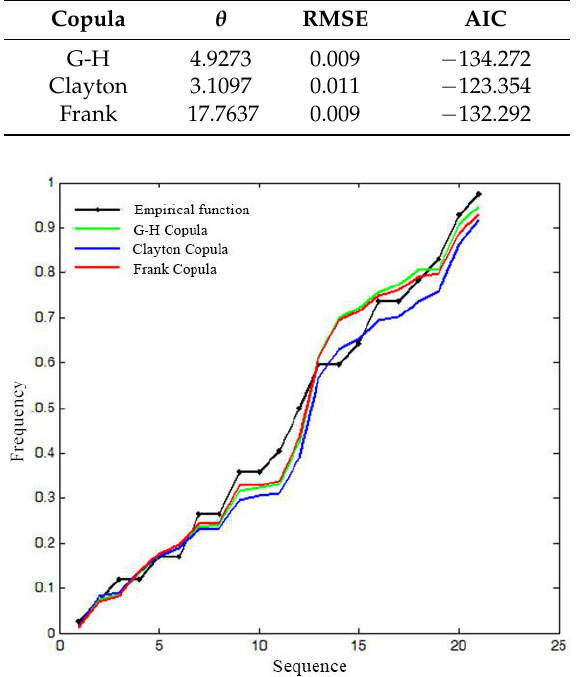
Table 7. The goodness-of-fit test for the bivariate Copula function.